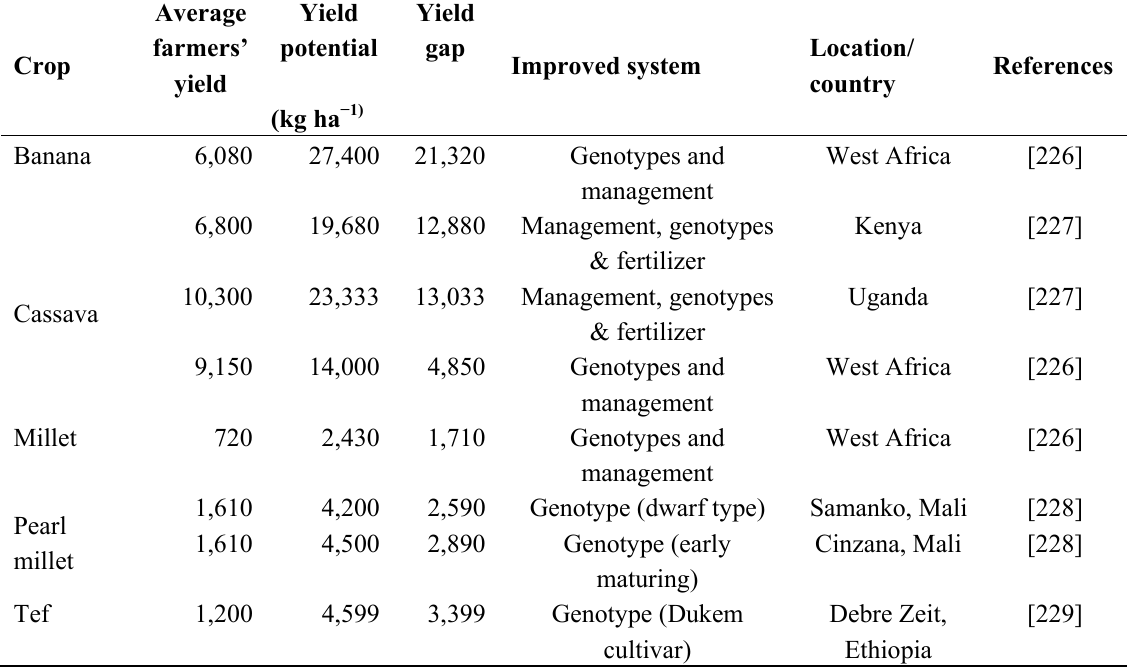
Table 4. Potential yield and yield gap for some understudied crops in Africa. The average farmers’ yields for millet and tef were based on: millet in Mali [23], tef in Ethiopia